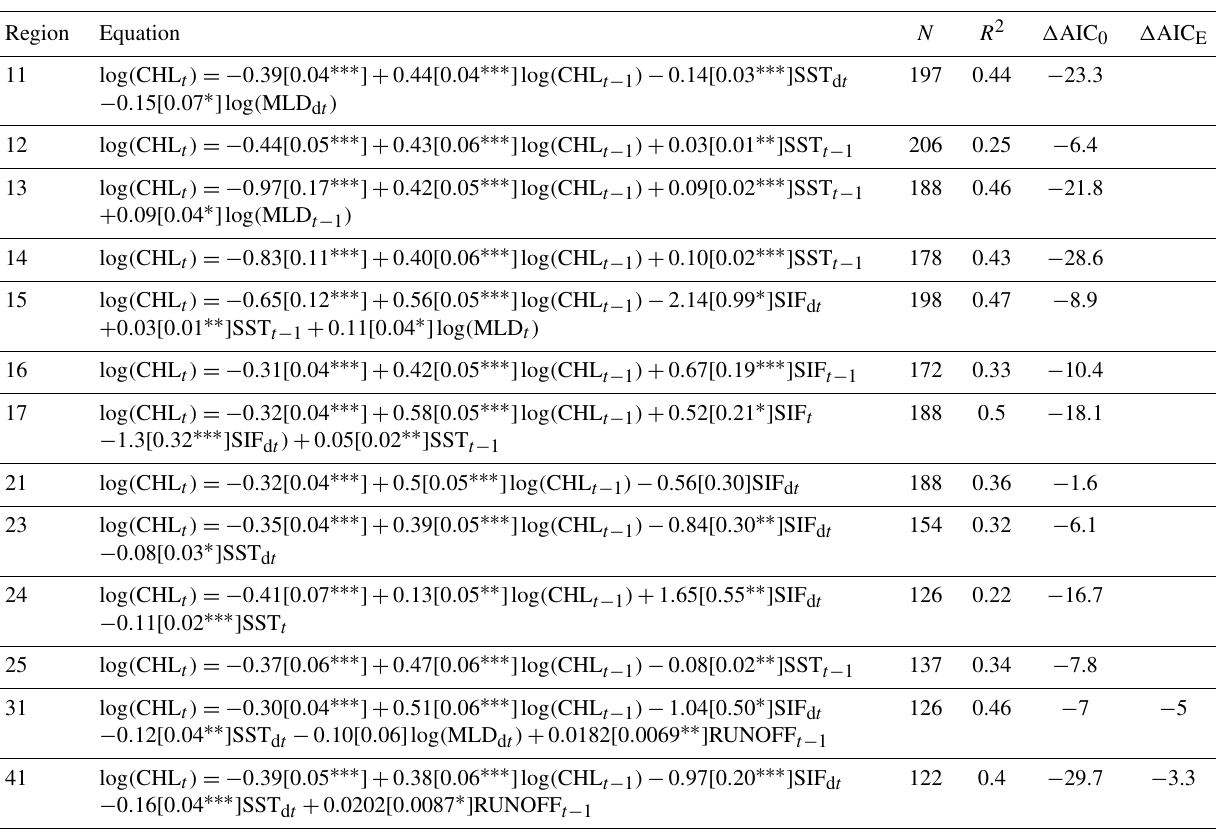
Table A2. Summary of models for regions within 10 to 20km from the coast. The model equations give parameter estimates with standard errors and statistical significance in brackets ( ∗ P < 0 . 05 ; ∗∗ P < 0 . 01 ; ∗∗∗ P < 0 . 001). N is the sample size, and R 2 is the proportion of variance explained. (cid:49) AIC 0 is the difference in the Akaike information criterion corrected for small sample size between the selected model and a null model with CHL in the previous time step, log ( CHL t − 1 ) , as the only predictor. (cid:49) AIC E is the difference in the Akaike information criterion corrected for small sample size between the selected model and an environmental model with RUNOFF excluded from the predictor